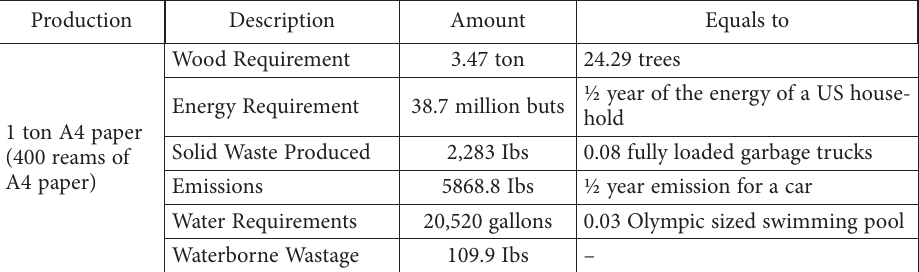
Table 2. Environmental impact of paper consumption (source: Standard Chartered Bank,